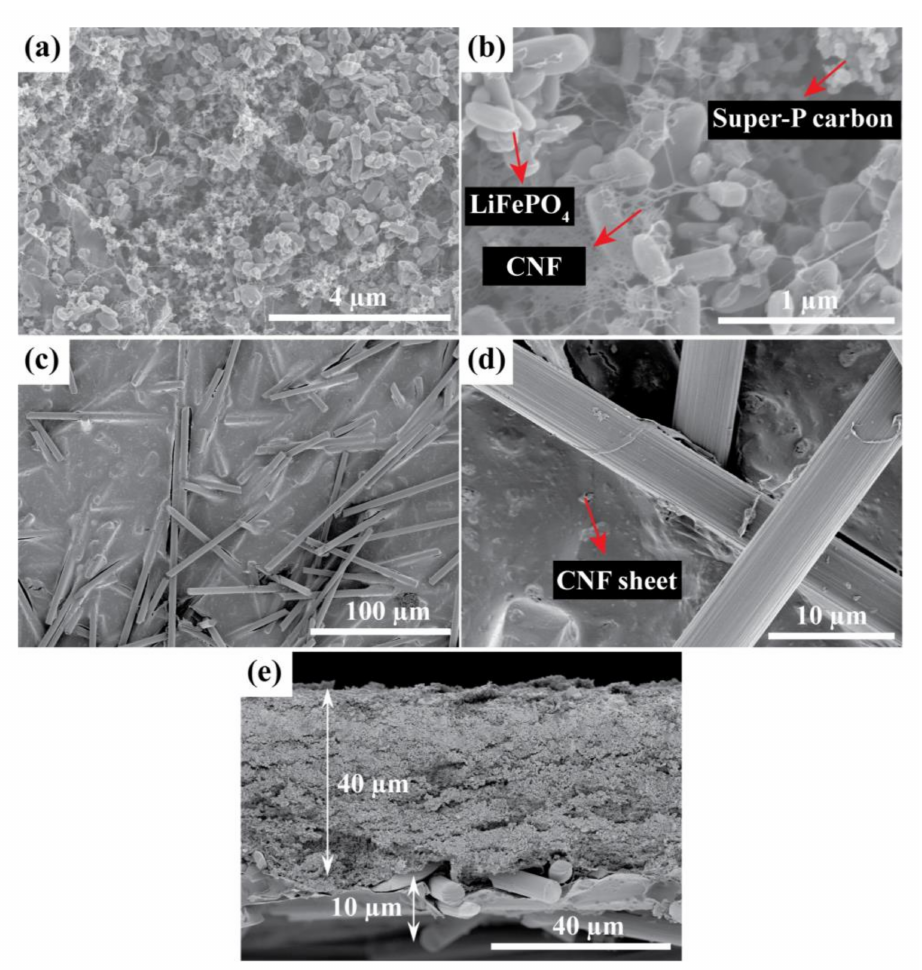
Figure 4. SEM images of the LFP-CF electrodes at different magnifications: ( a , b ) LFP layer surface morphology; ( c , d ) CF layer morphology; and ( e ) cross-sectional SEM